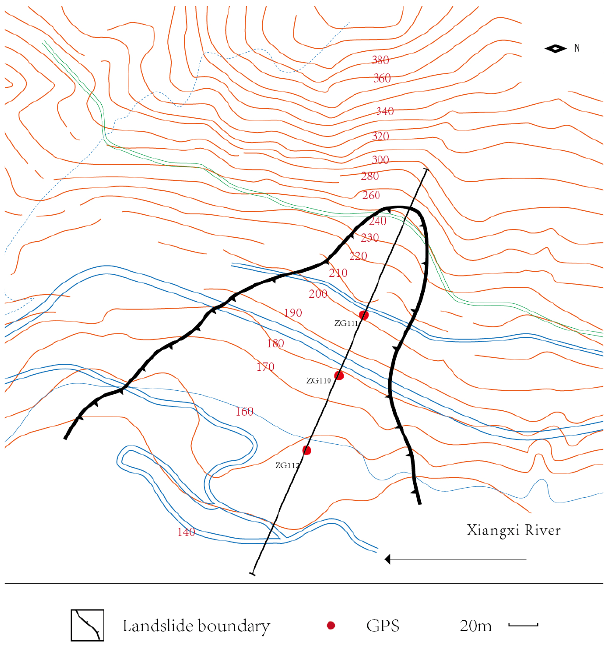
Figure 8. The topographic map of the Bazimen landslide .